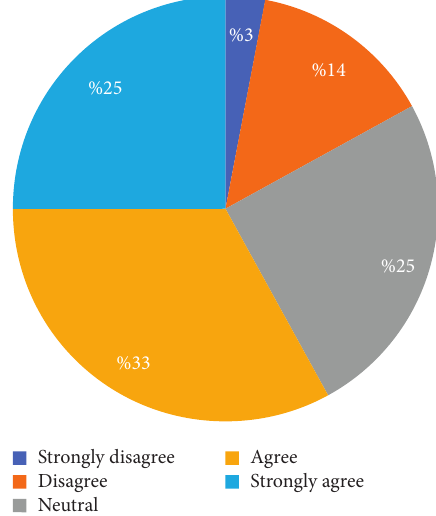
Figure 5: Q3: I think applying open data will reduce time, human errors, and